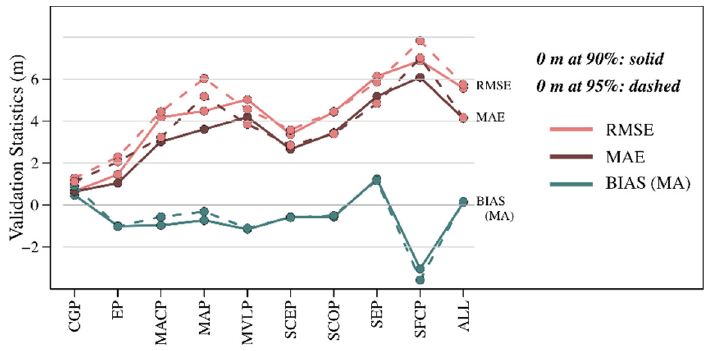
Figure 7. Validation statistics by ecoregion and for all ecoregions